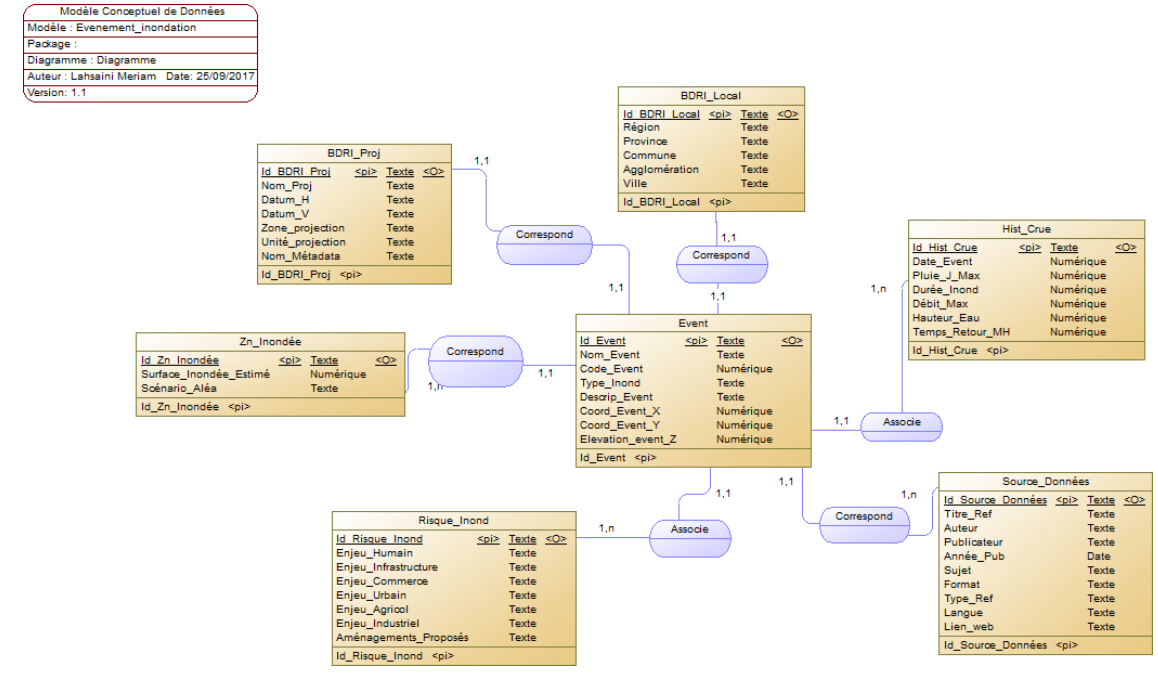
Fig. 1: Conceptual Data Model "Event" in PowerAMC